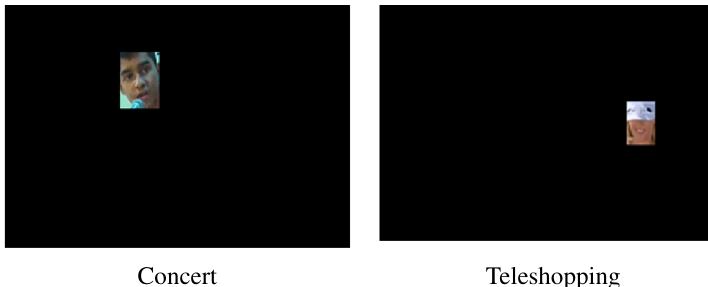
Fig.4 The results of face detec- tion method for Concert and Teleshopping images shown in Fig.